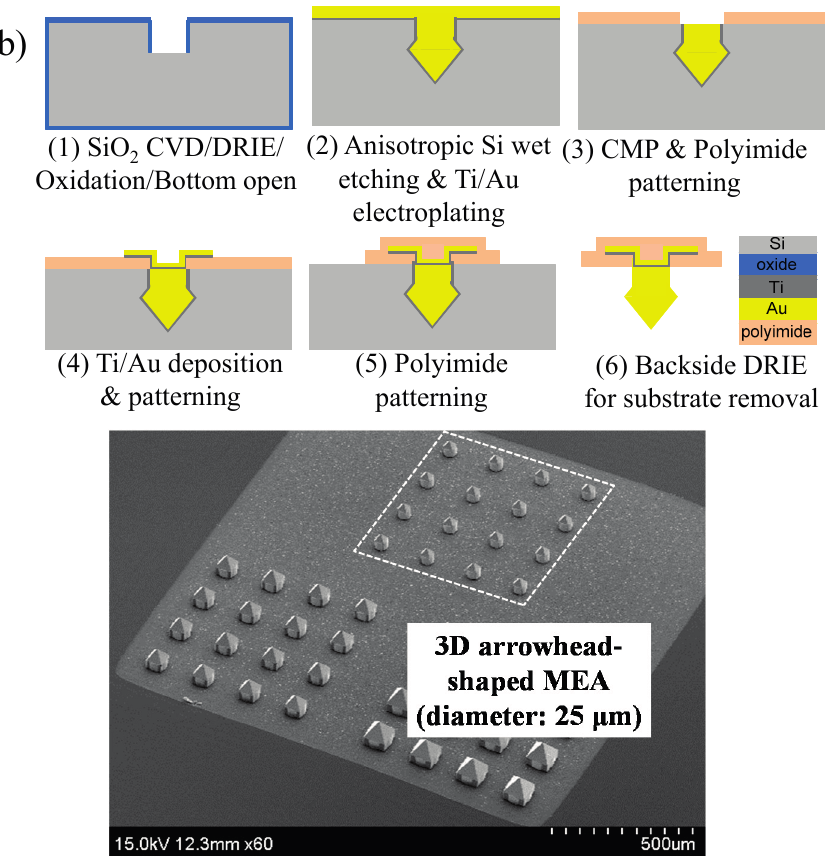
Figure 1. Fabrication processes and results. ( a ) 2D Au MEA; ( b ) 3D Au